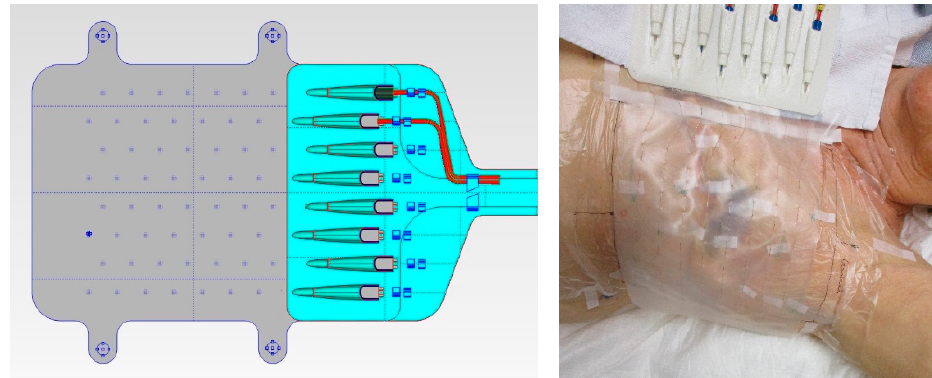
Figure 2. The left picture is a schematic drawing of the thermal monitoring sheet (TMS; Medlogix, Rome, Italy). Dimensions of the transparent silicone sheet are 212.5 × 166 × 0.3 mm (l × w × h) with eight seven-sensor thermocouple probes resulting in a monitoring area of 162.5 × 140 mm. The right picture shows a photograph of the TMS on the chest wall of a study patient.